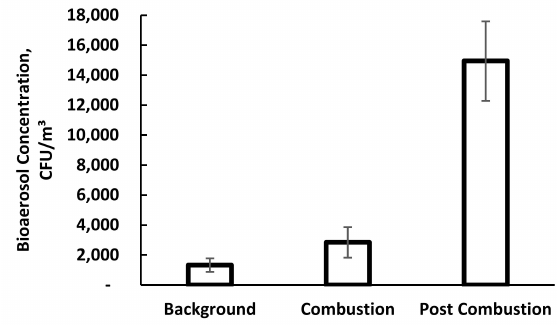
Figure 4. Concentration of culturable bacteria in the ambient air collected with a personal sampler in the Cainbable series of experiments. Error bars represent the standard deviation of three experimental runs.